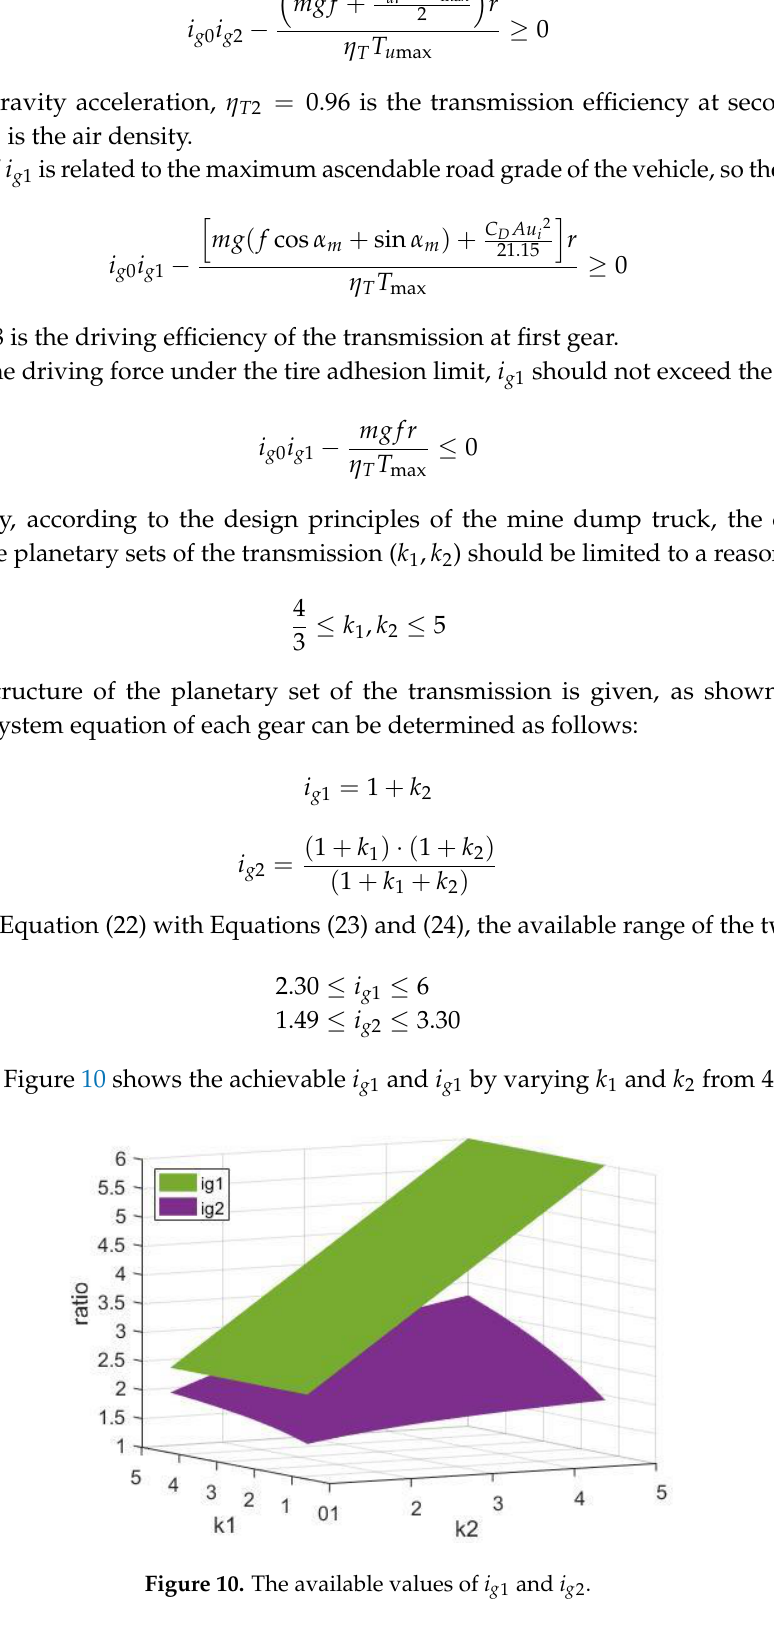
Figure 11. Iron mine.